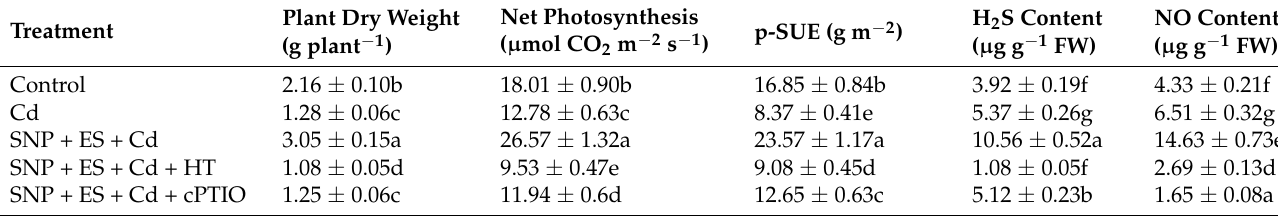
Table 7. Effect of 100 µ M SNP (NO donor) and 200 mg S kg − 1 soil of elemental sulfur (ES) in